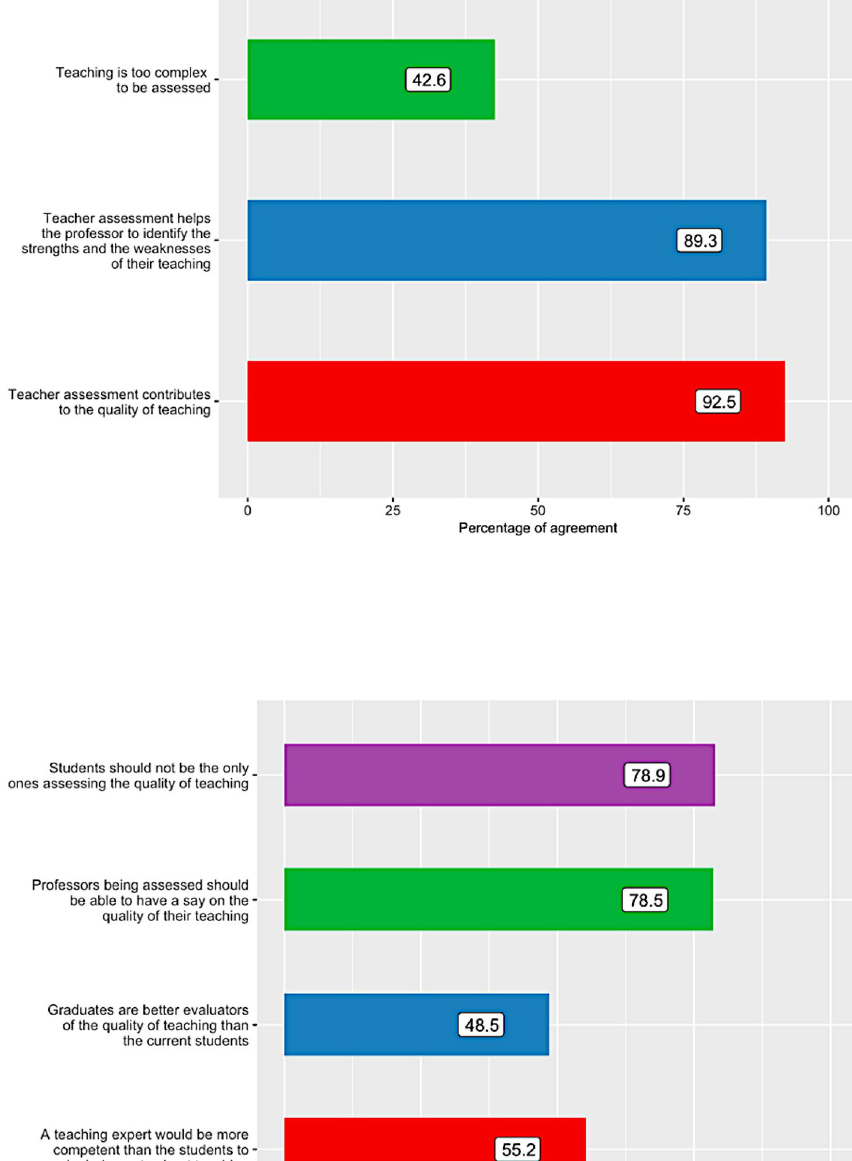
Fig. 1 Percentage of respond‑ ents who say they "somewhat agree or strongly agree" about the usefulness of teacher